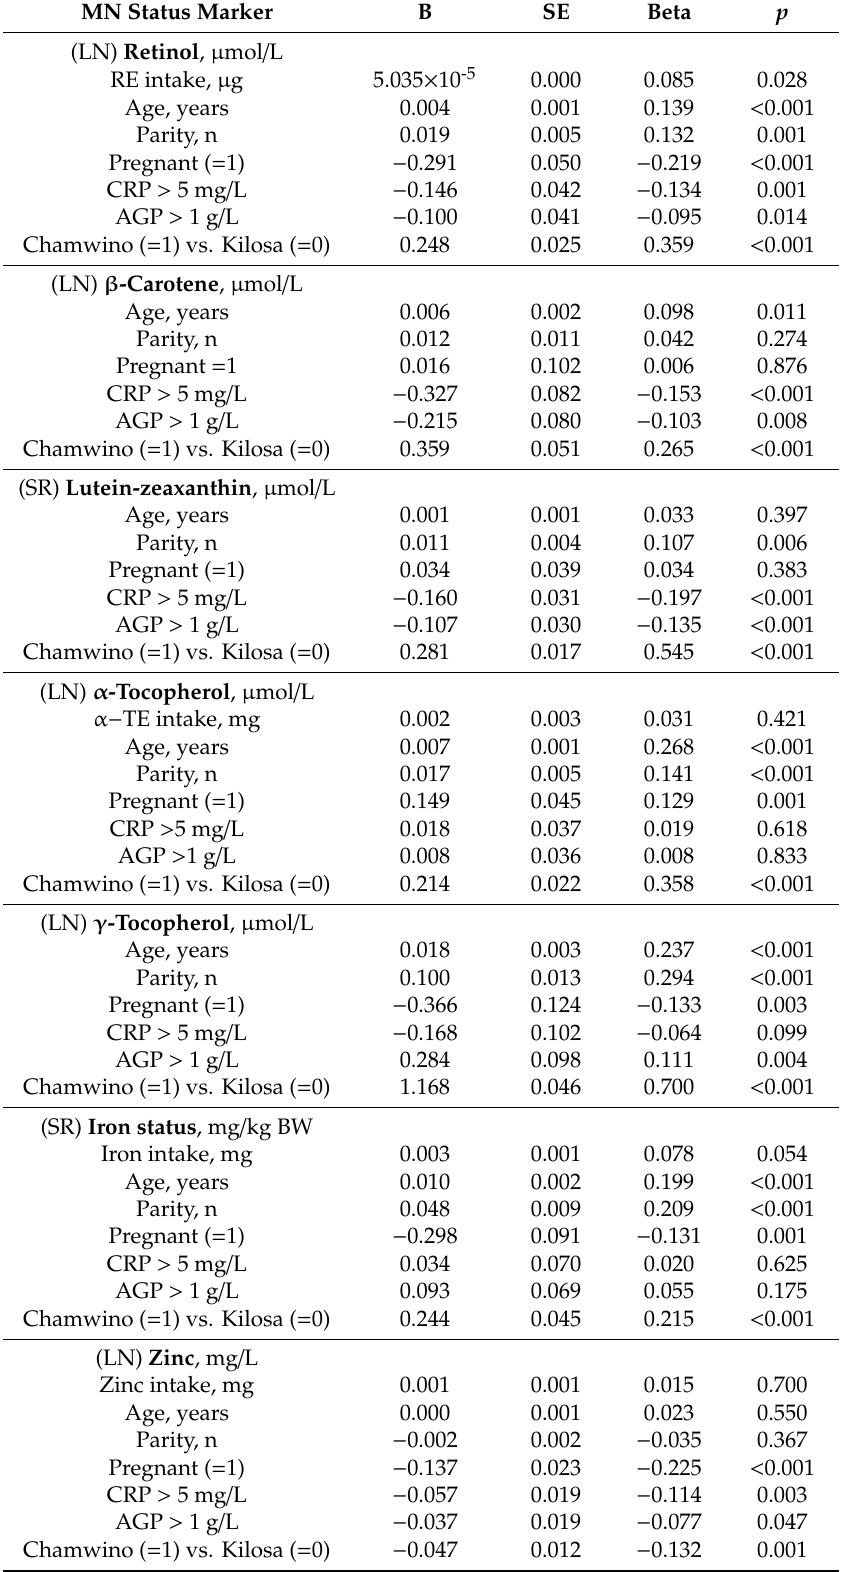
Table A2. Determinants of serum micronutrient status